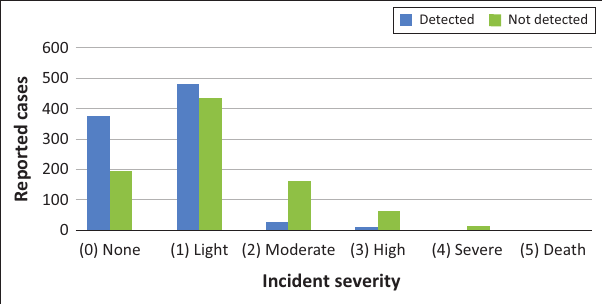
FIGURE 9: Incident severity with outcomes if the incident was detected compared with if it remained